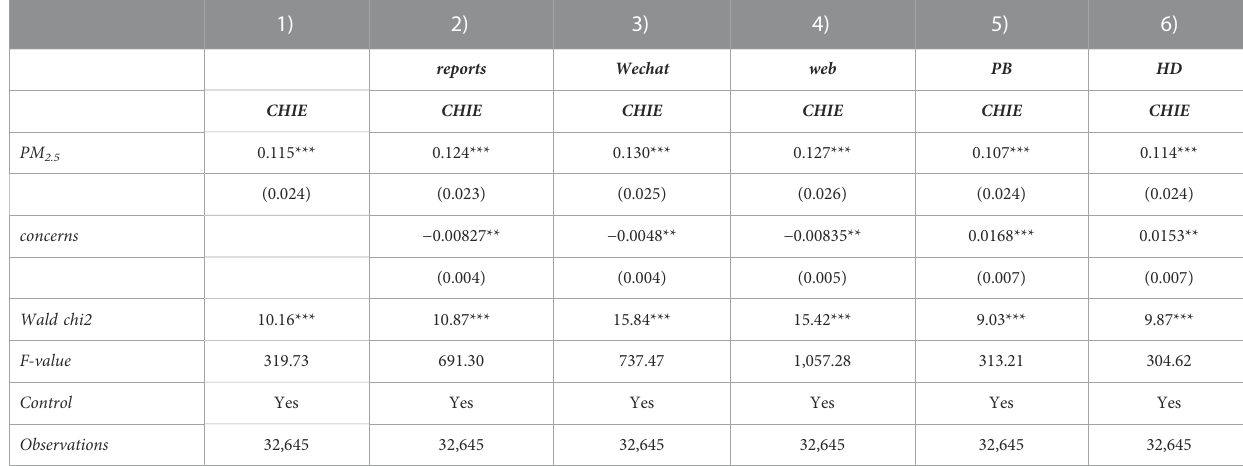
TABLE 5 Results of the mechanism test with CHIE.